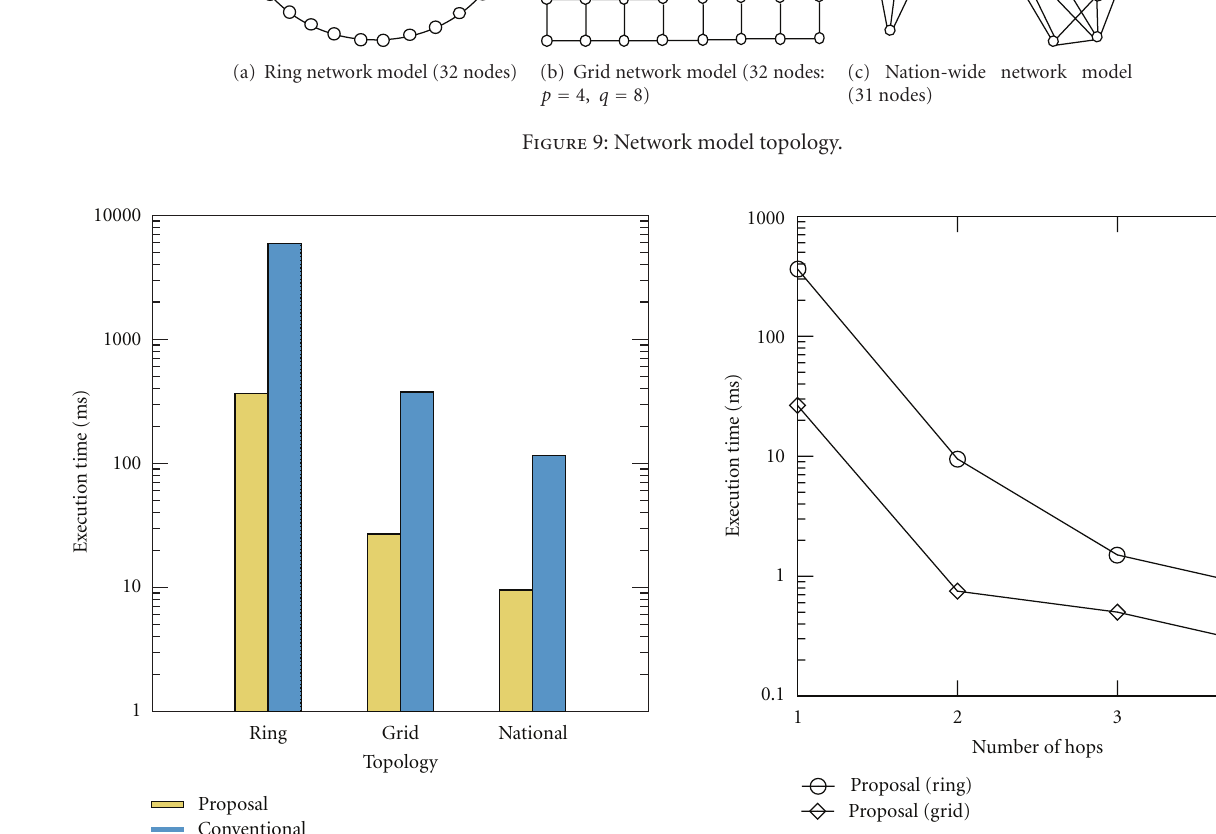
Figure 10: Execution time of the proposed algorithm and the con- ventional algorithm on ring, grid, and nation-wide server networks.